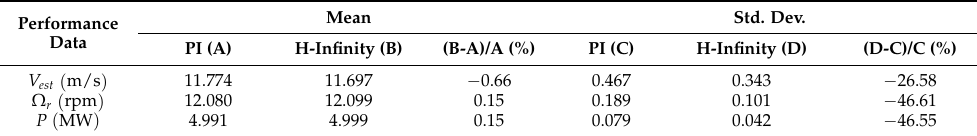
Table 6. Comparison of EOG results for performance data in 12 m/s noiseless environment.